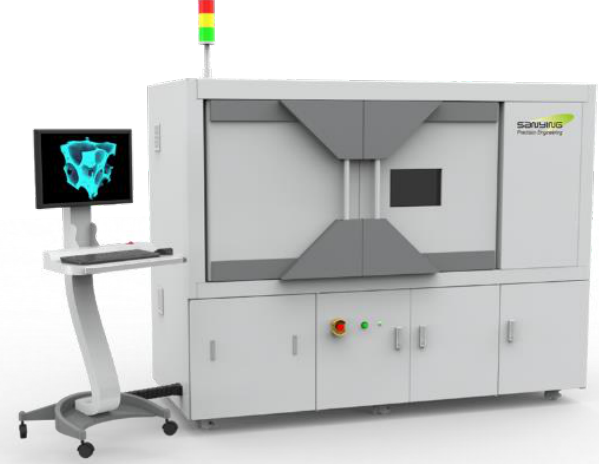
Figure 3. nanoVoxel-3000